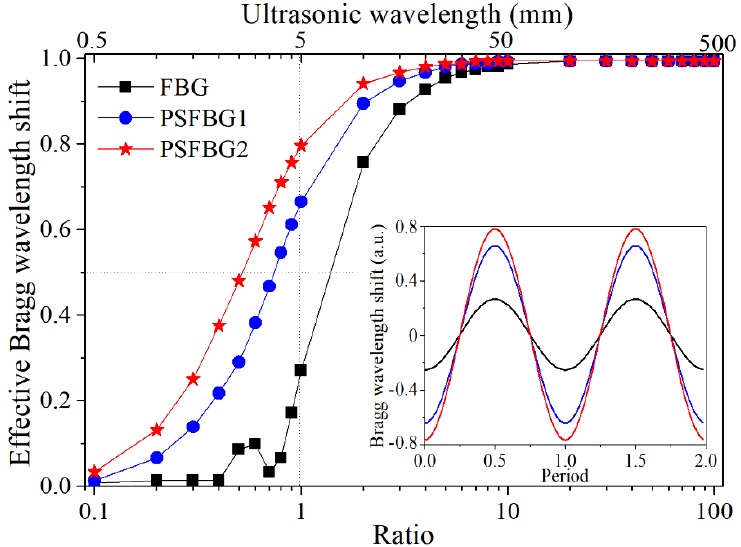
Figure 3. The responses of FBG and PSFBGs to longitudinal waves with different ultrasonic wavelengths. The inset shows the time-domain Bragg wavelength shifts of FBG and PSFBG.